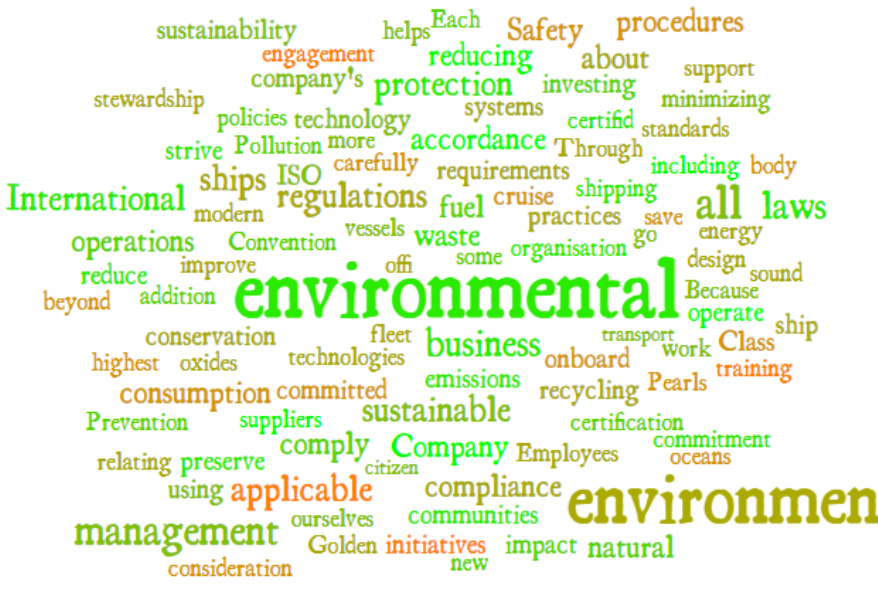
Figure 2. “ Word cloud ” demonstrating the relative word frequencies in the environment-related Figure 2. “Word cloud” demonstrating the relative word frequencies in the environment-related passages of the analyzed codes of conduct. passages of the analyzed codes of